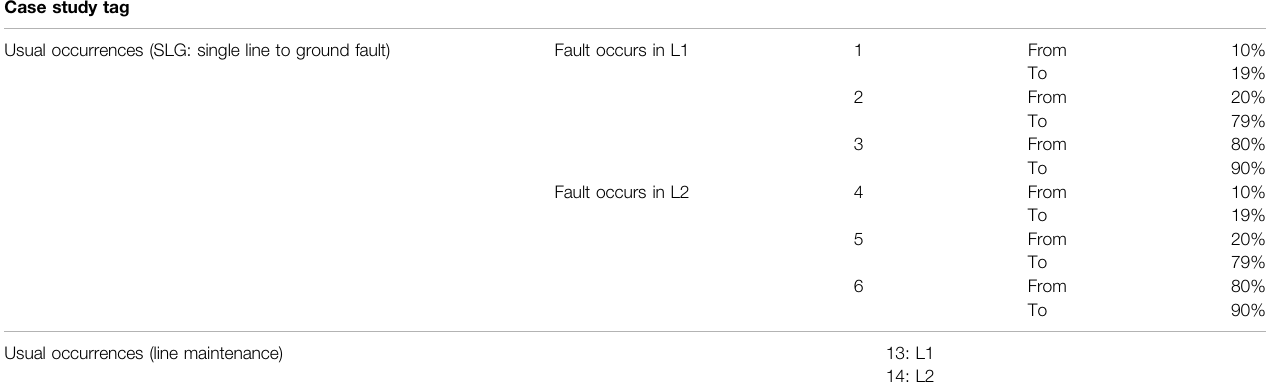
TABLE 2 | Natural event case studies in MSU/ORNL